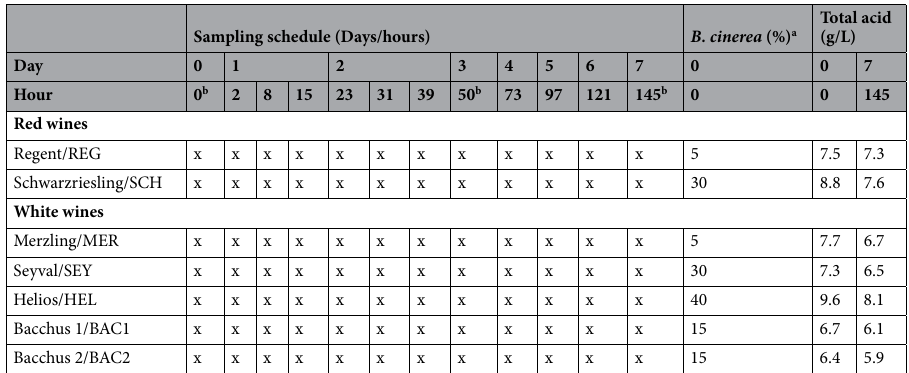
Table 1. Sample and metadata overview. The first sample of each wine was collected immediately before inoculation with the yeast starter culture. BAC2 grapes were treated with combi-protec with insecticide SpinTor (Belchim Crop Protection). a Infectious burden as percentage of affected grapes. b Samples selected for